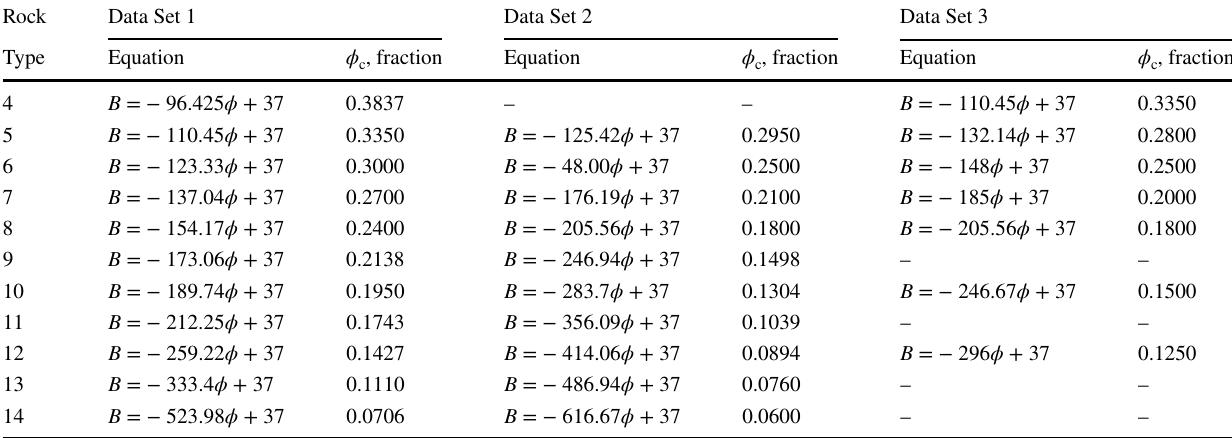
Table 1 The relationship between porosity with bulk modulus and critical porosity value for each rock Rock Data Set 1 Data Set 2 Data Set